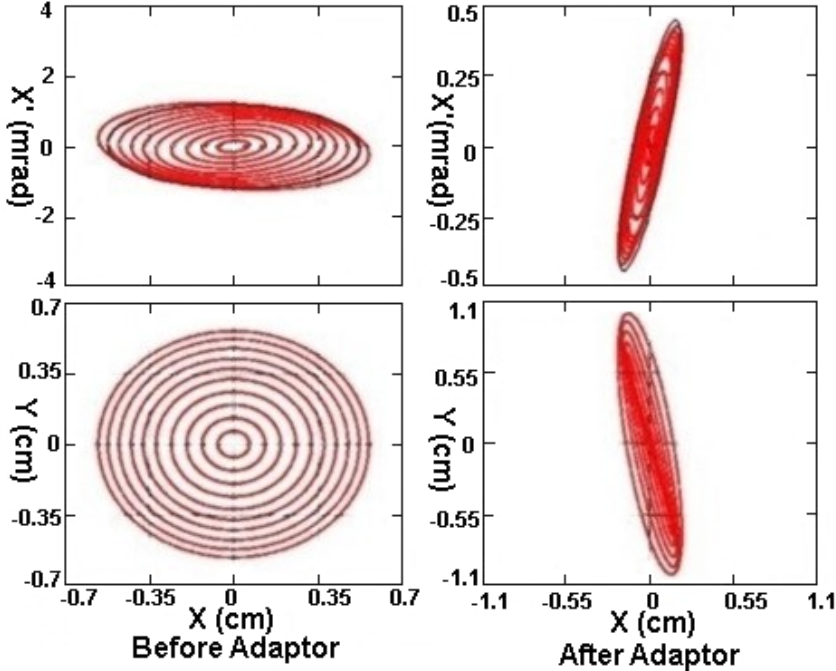
FIG. 3. (Color) Phase space structure before and after adaptor.